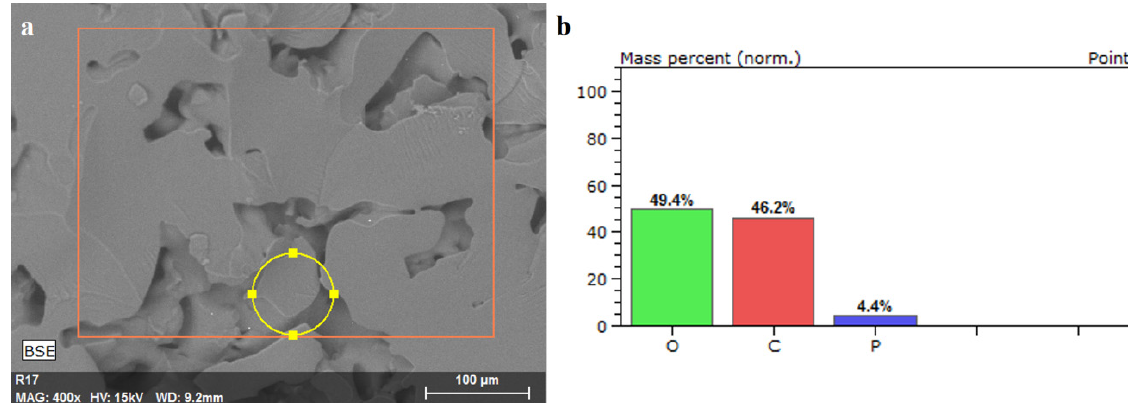
Figure 7. ( a ) SEM analysis and ( b ) EDX analysis of sample PE1.